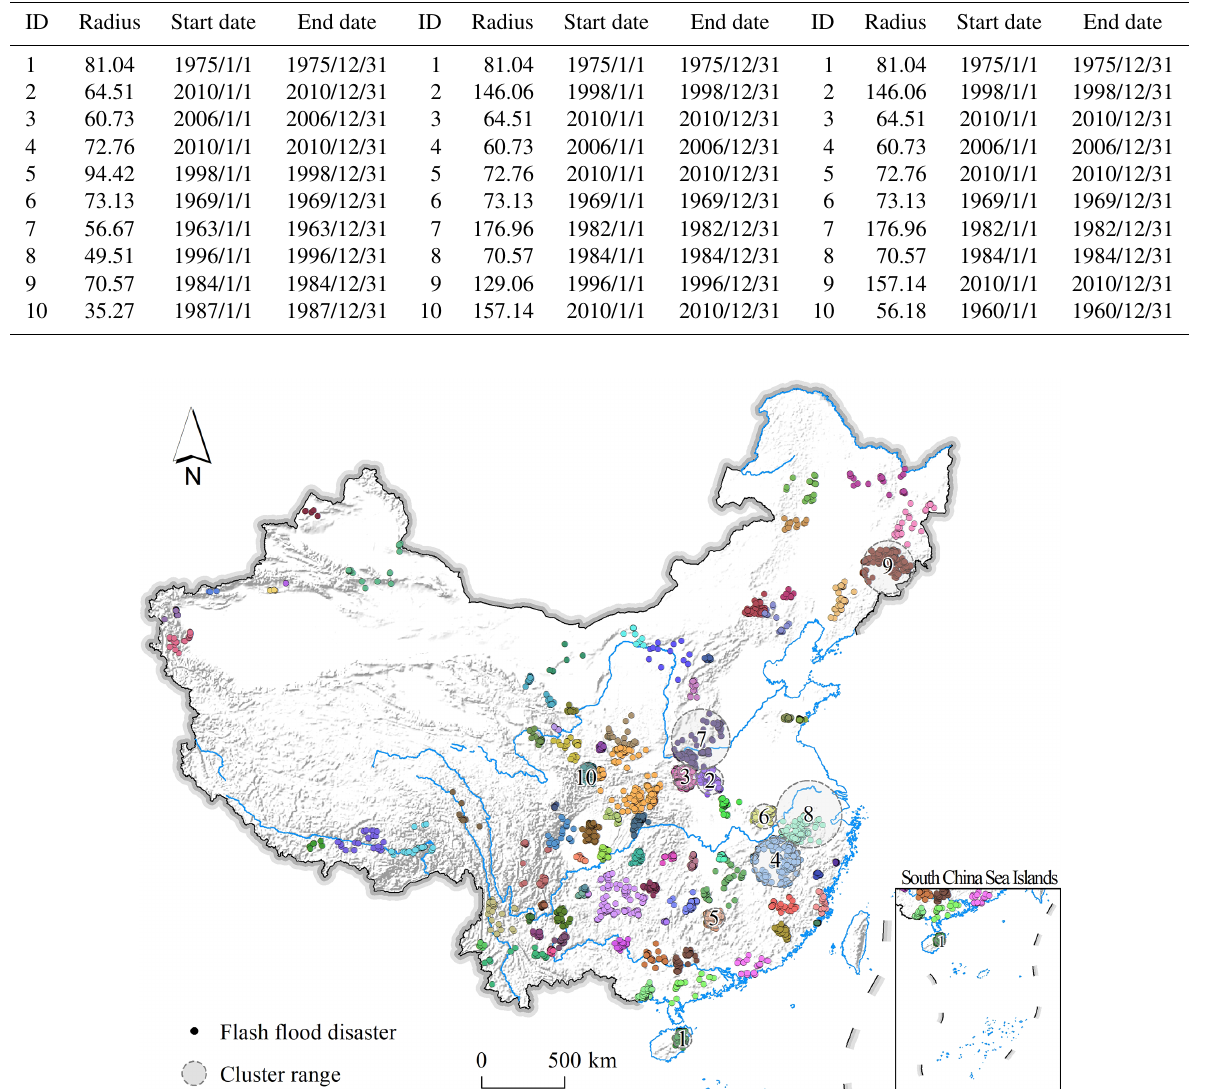
Table 2. Temporal duration of the first 10 clusters of flash flood disasters detected via three different models (left: R max = 100km; center: R max = 200km; right: R max = 300km).